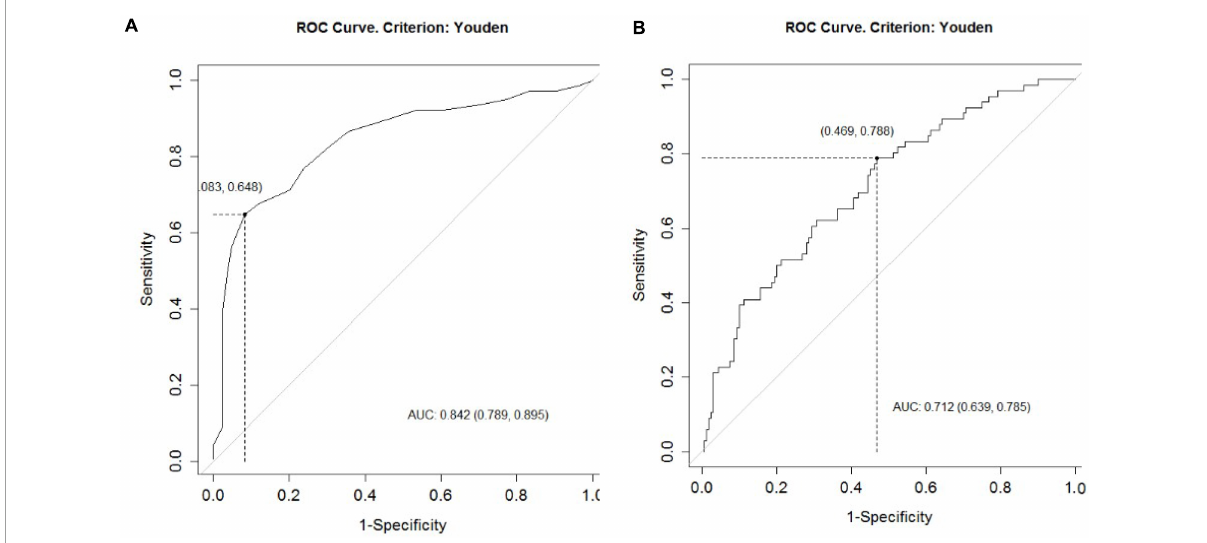
FIGURE2 The ROC curve predicts ICU admission based on the initial CAD4COVID-CT evaluation. The AUC (95% CI) and optimal cutoff determination for the CT-SS to predict (A) risk of ICU admission and (B) risk of mechanical ventilation.